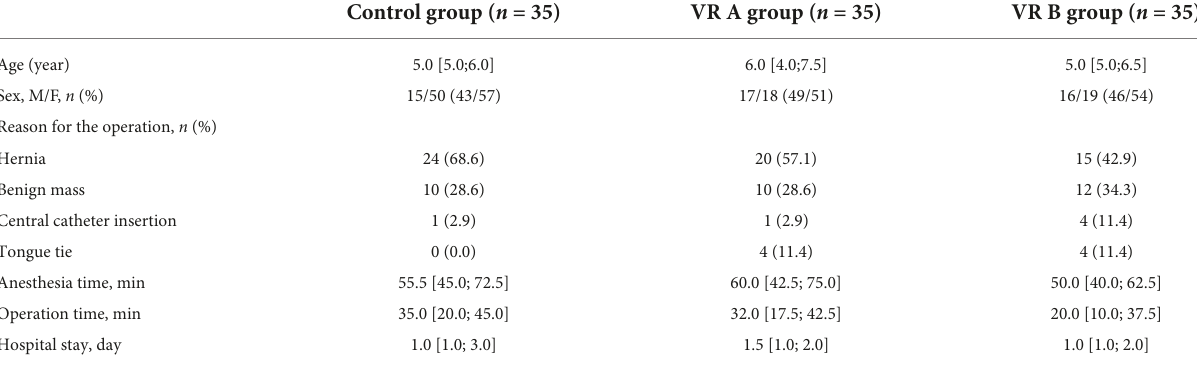
TABLE 1 Patient characteristics.